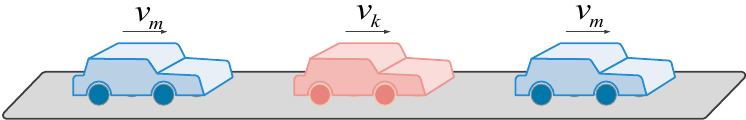
v to v in the charging area. Figure 5. Driving speed of a single EV changes from v k to v m in the charging k m